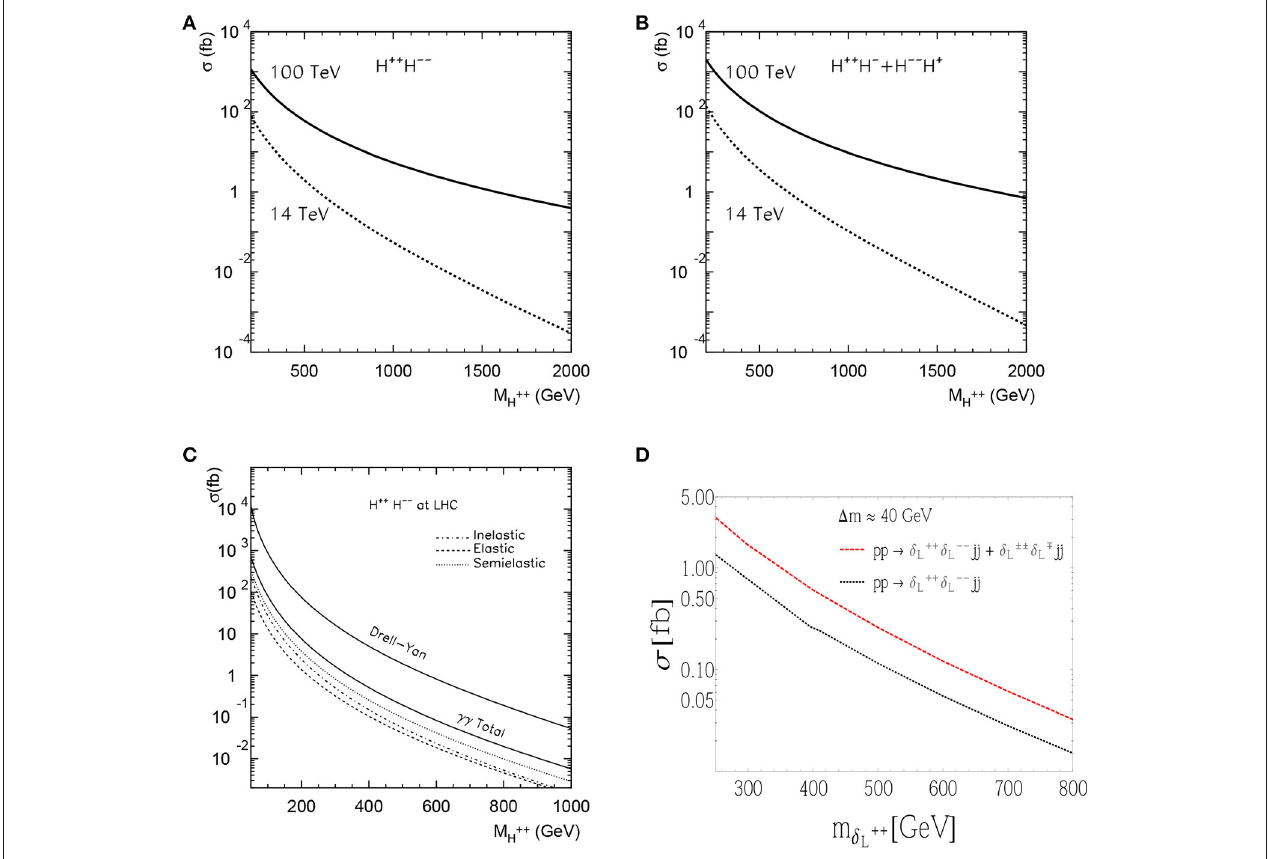
H ++ H −− and (B) H ±± H ∓ at √ s → 14 TeV =